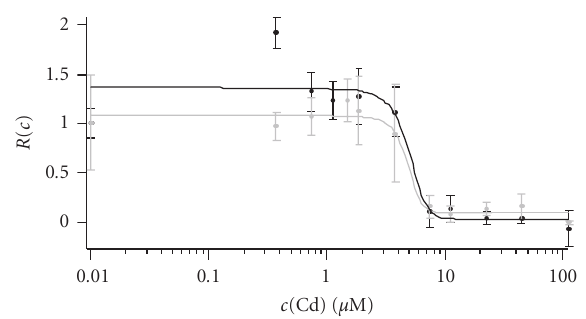
Figure 4: Experimental evaluation of cytotoxicity of polymer- coated CdSe nanoparticles. Toxicity to NIH-3T3 fibroblasts of a NC-containing solution was estimated after 48-hour application. Dose-response curve for cell viability was measured with a Re- sazurin assay [74]. Reazurin is a nonfluorescent dye that is me- tabolized in functional mitochondria and converted into resorufin which fluoresces red. Black and grey curves show two experiments ( n = 8 measurements each). Normalized survival R(c) after applica- tion of a Cd 2+ concentrationc(Cd) was estimated from the change in absorbance of the converted dye measured at 600nm. Changes in R became significant at c (Cd) around 3–5 μ M, whereby c (Cd) refers to the concentration of Cd 2+ on the surface of the CdSe nanoparti- cles, which accounts for the di ff erent toxicity of di ff erent-size NCs. This concentration of Cd 2+ corresponds to a concentration of CdSe nanoparticles of 50-70nm. Similar data was obtained with a cell adhesion assay [71] (not shown). In contrast for free cobalt ions (Co 2+ ), cytotoxic e ff ects became significant at around 50 μ M (data not